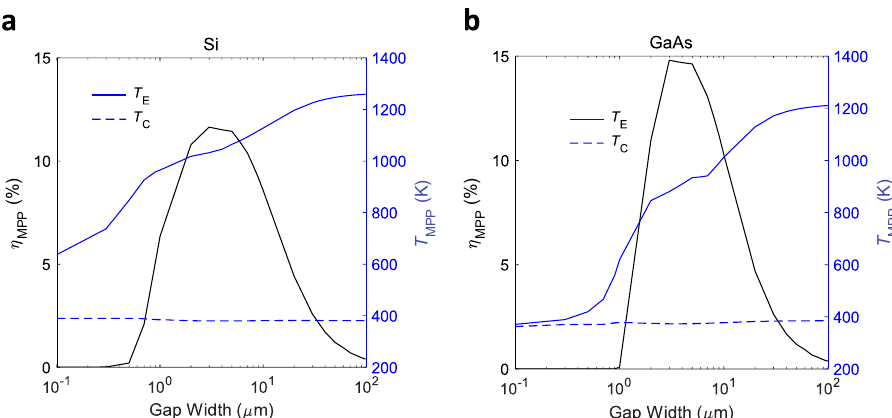
Fig. 4 Trends in thermionic solar conversion ef fi ciency and electrode temperatures as a function of the interelectrode gap width. The data are shown for a Si and b GaAs at MPP under a solar concentration ratio of 100. The symbols with subscript E and C represent the emitter and collector temperatures, respectively.